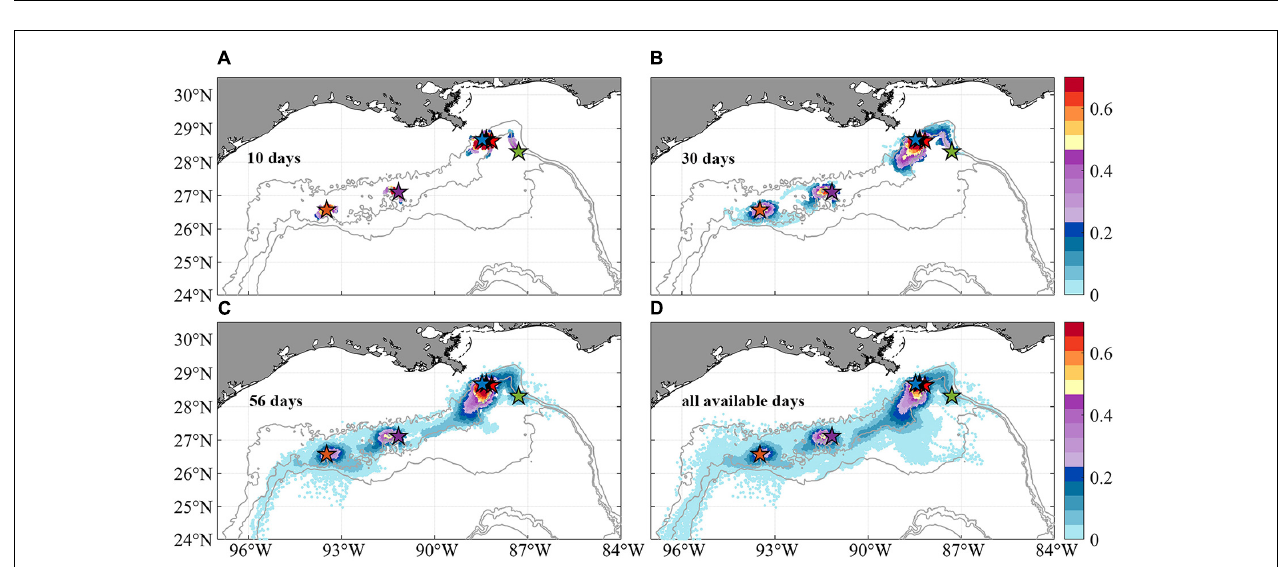
FIGURE 6 | Horizontal probability distribution of Lagrangian larval particles after their release at the six sampling sites (colors indicate probability values). Maps of the kernel density estimation (KDE) of particles passages during periods of 10 days (A) , 30 days (B) , 56 days (C) , and all available days ( D , 56 days in February, May, and August, and 148 days in November) since release. Subsampling (sample every 20 particles spatially and 2 days temporally) has been applied for plotting. Few larval particles that are displaced more than 800 m in the vertical direction away from the bottom are removed to focus on near-bottom processes.